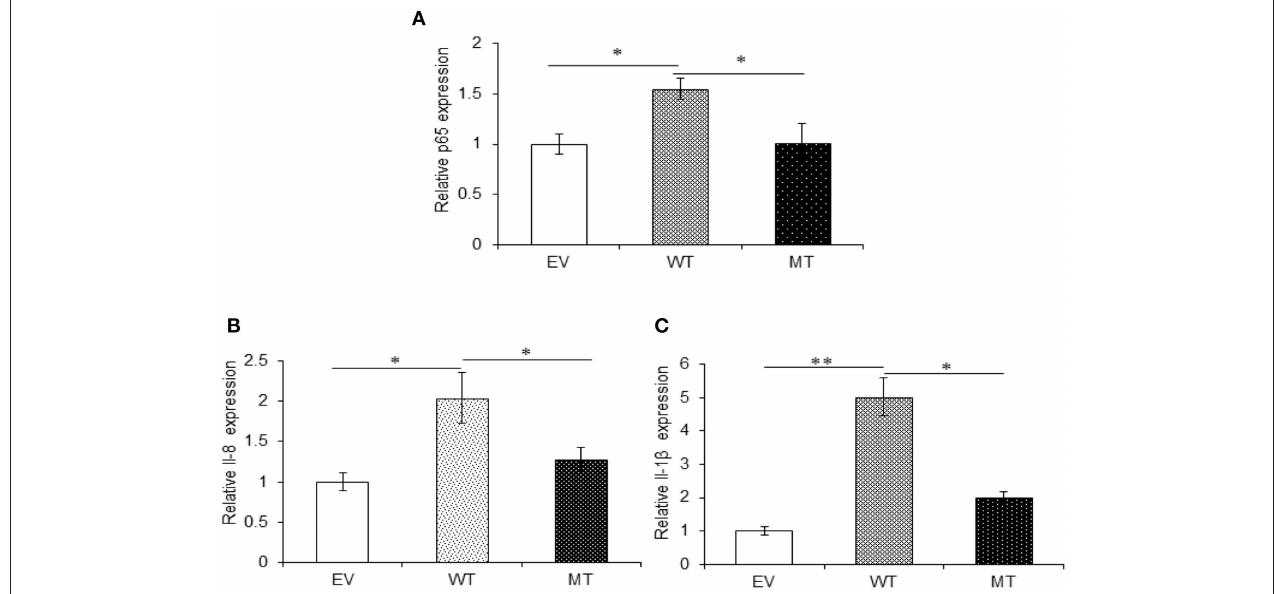
FIGURE 8 | A20 absence results in an increased pro-inflammatory response. miR-125b and A20 were co-transfected in HT29 cells for 48h and stimulated with 100ng/ml of LPS. After 6h of stimulation, RNA was isolated and reverse transcribed to investigate the mRNA expression of p65, IL-8, and IL-1 β through qRT-PCR. p65 (A) , IL-8 (B) , and IL-1 β (C) showed significant rise in their expression in the miR-125b overexpressed cells where it suppressed the expression of A20. While in the presence of mutant miR-125b, their expression showed a marked decrease. GAPDH gene was used as an internal reference. P < 0.05 were statistically significant. Significance was estimated with respect to the pBABE-puro empty vector control group. * p ≤ 0.05, ** p ≤ 0.01. EV, empty vector; WT, wild type; MT, mutant. Bars represent standard error of the mean (SEM).